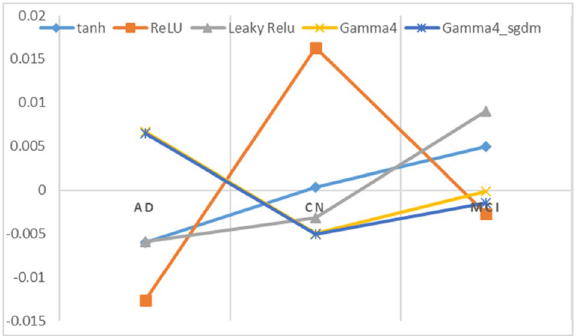
Figure 11. Bias value plot of final FCL layer from the baseline CNN model using different activation functions.